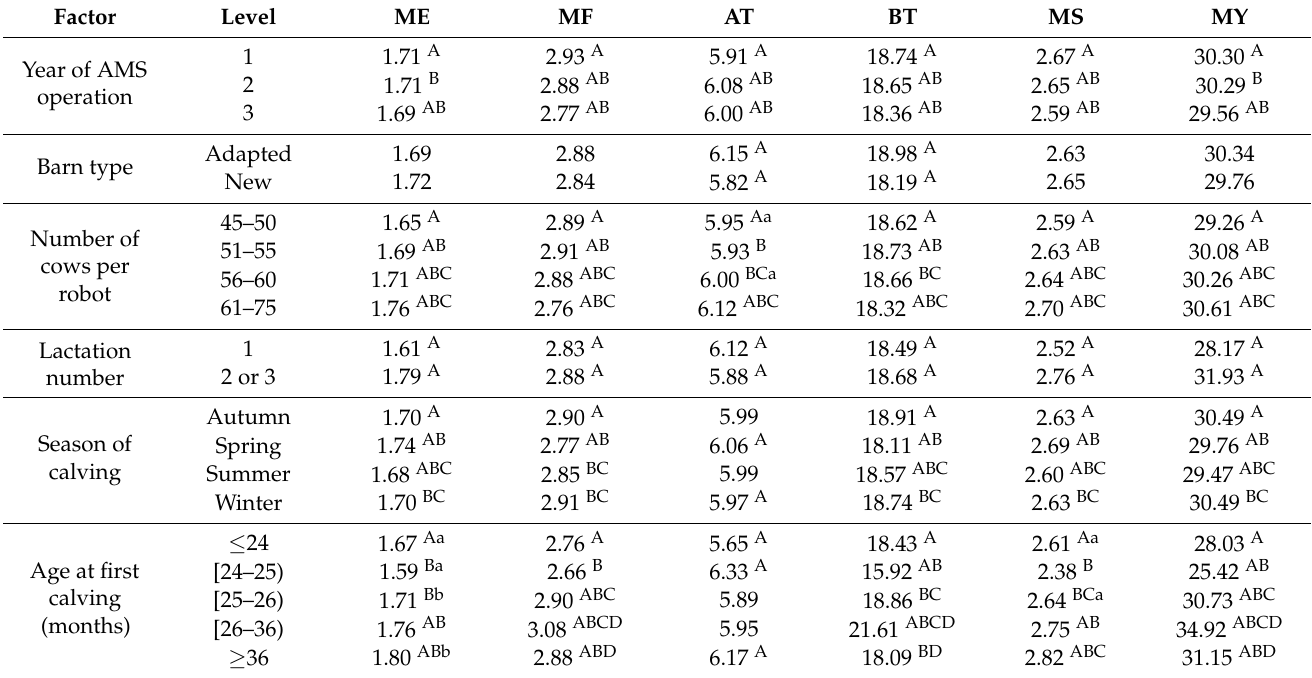
Table 3. Impact of selected factors on tested traits (least square